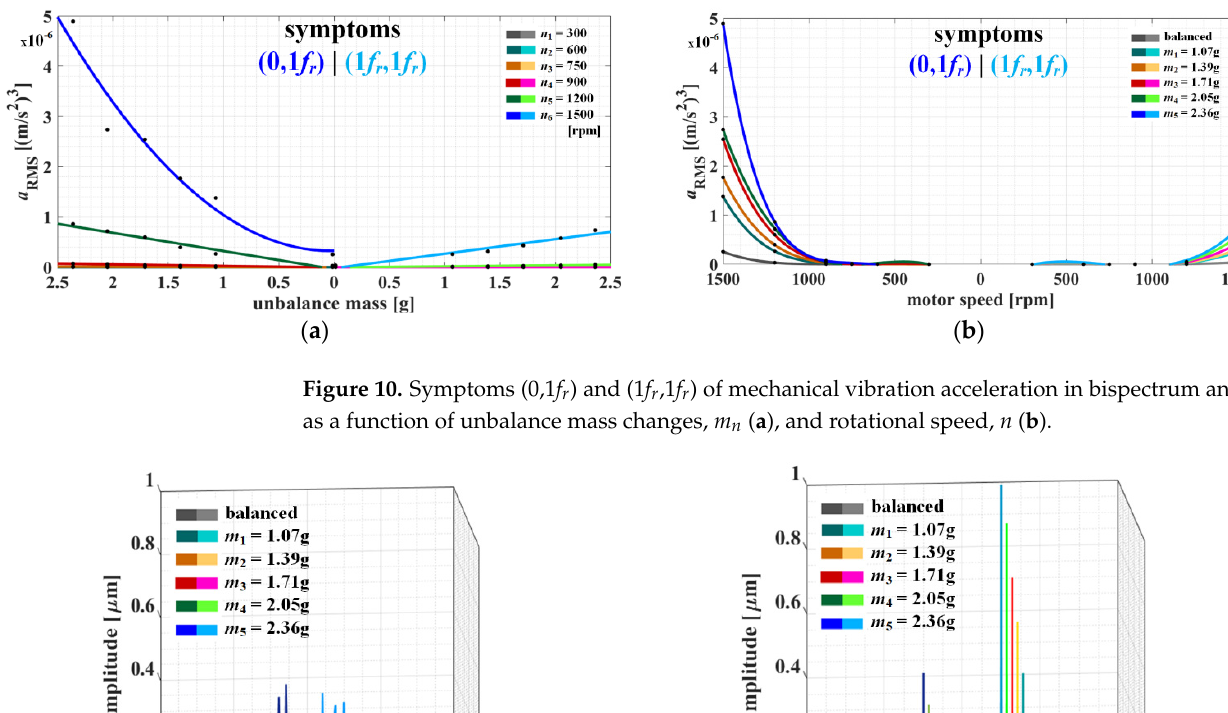
Figure 10. Symptoms (0,1 f r ) and (1 f r ,1 f r ) of mechanical vibration acceleration in bispectrum analysis as a function of unbalance mass changes, m n ( a ), and rotational speed, n ( b ).